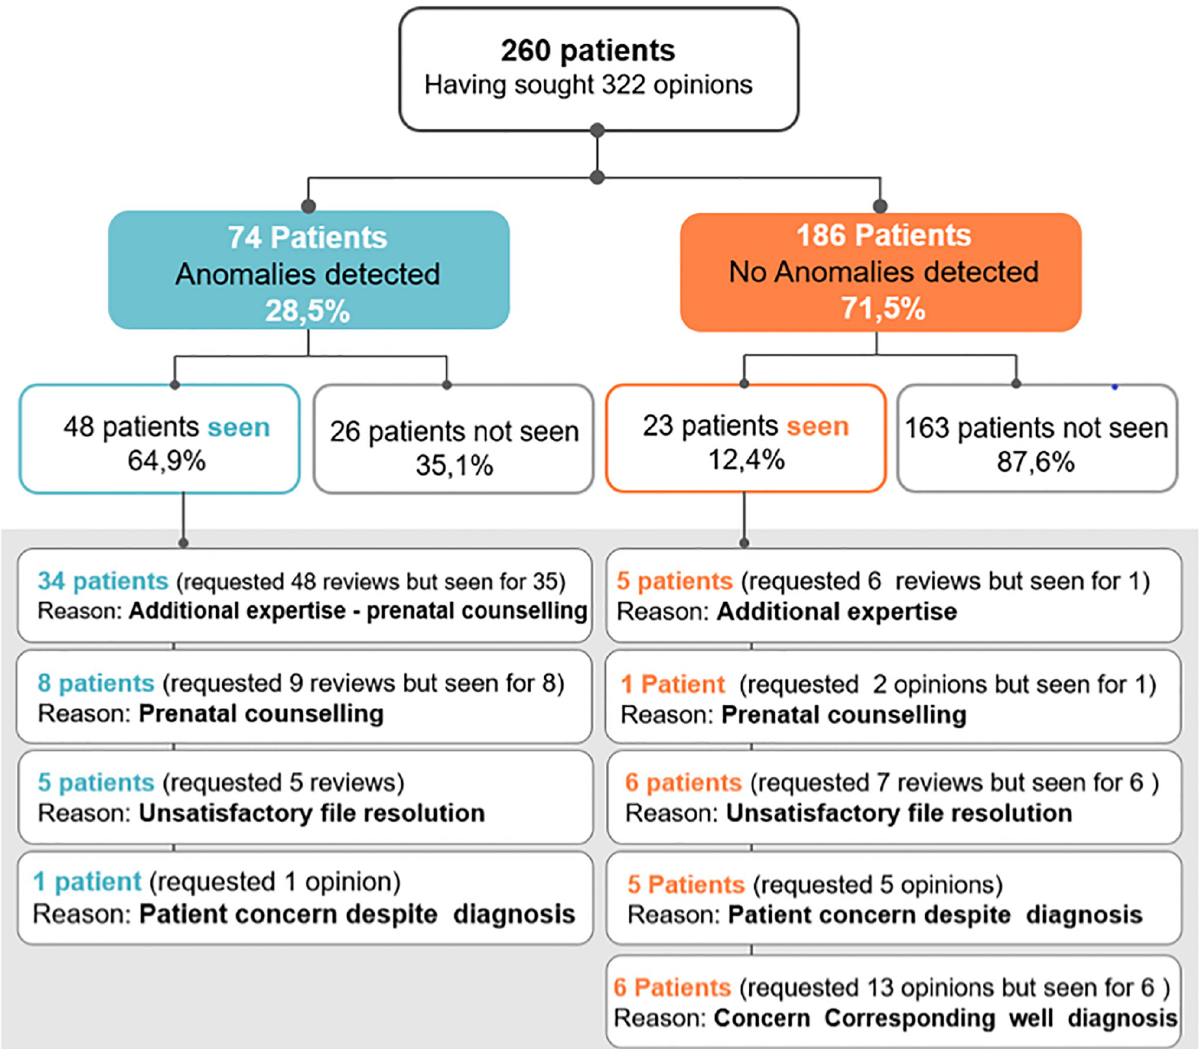
Fig 2. Breakdown of 260 patients who benefited from the tele-expertise strategy, with specific reasons for face-to-face consultations.